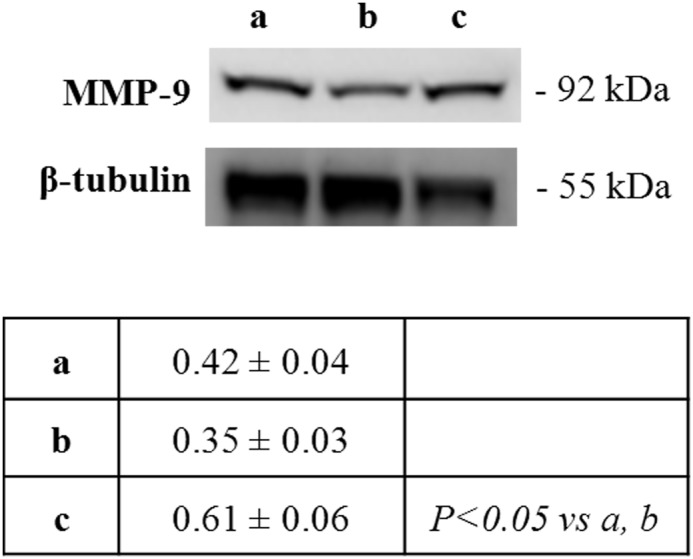
Severe hyperoxia increases liver expression of MMP-9.Western blotting analysis of MMP-9 expression in neonatal rat livers exposed to moderate and severe hyperoxia. a) ambient air; b) 60% hyperoxia; c) 95% hyperoxia. Each membrane has been probed with anti-tubulin antibody to verify loading evenness. Data are the densitometric measurements of protein bands expressed as mean values of Integrated Optical Intensity (IOI) (±SD).